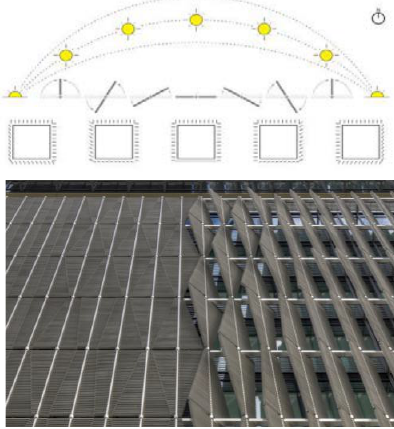
Figure 10. Different states of the sun-shading kinetic system Figure 11. Sunshade Diagram which re- sponse to the location of the